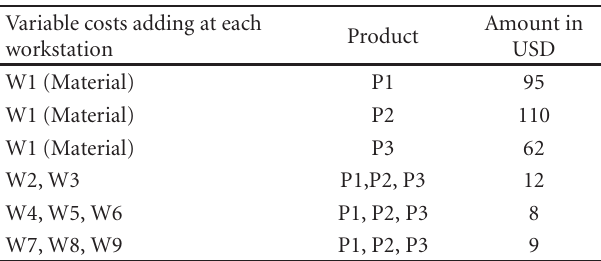
Table 3: Variable